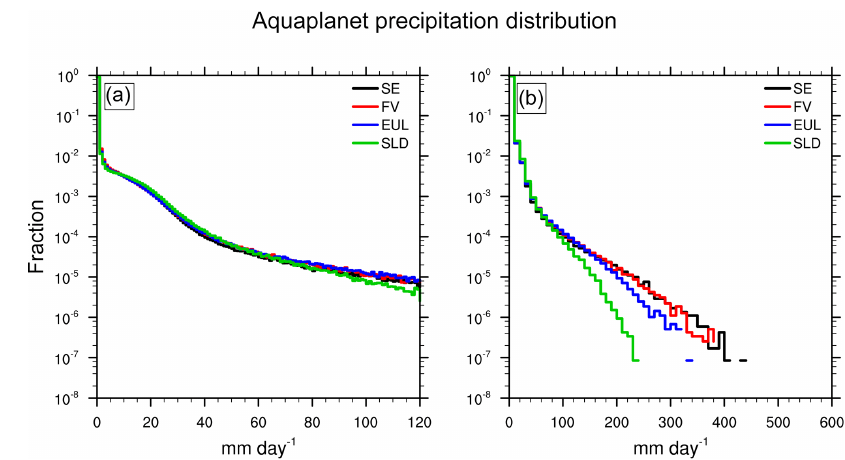
Figure 15. Same as Fig. 14 but for the CAM5 APS configurations of SE (black), FV (red), EUL (blue), and SLD